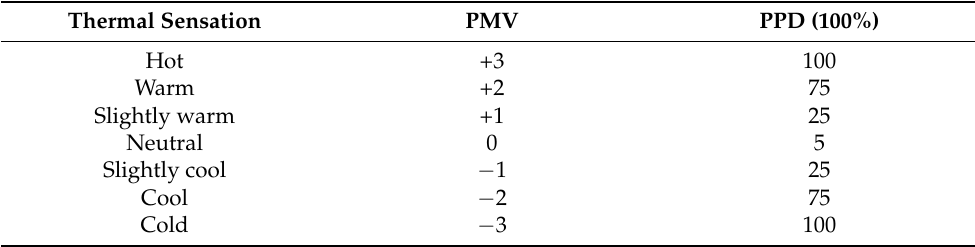
Table 1. PMV–PPD